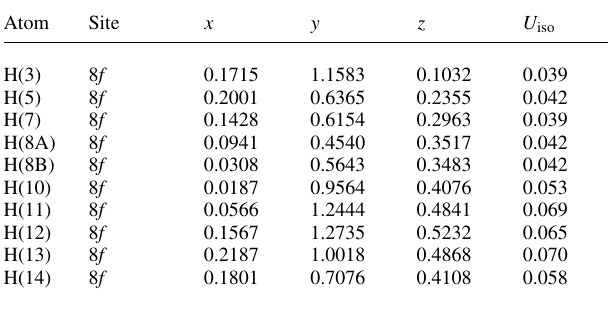
Table 2. Atomic coordinates and displacement parameters (in Å 2 )